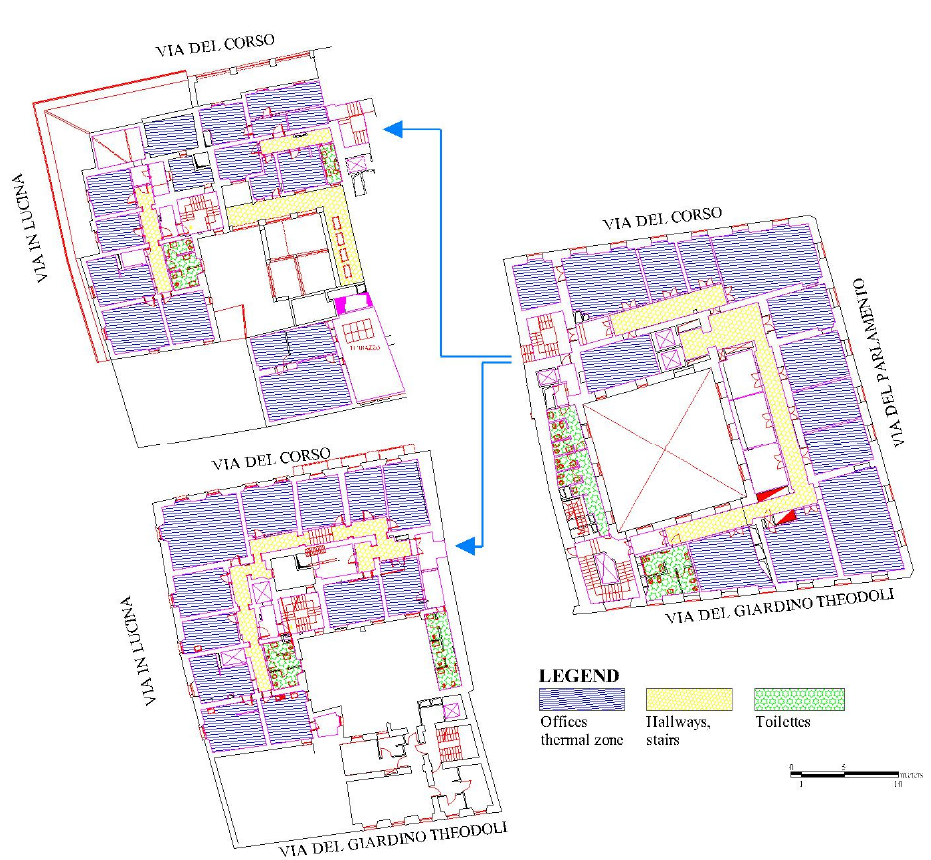
Figure 7. Designated uses on the third floor.